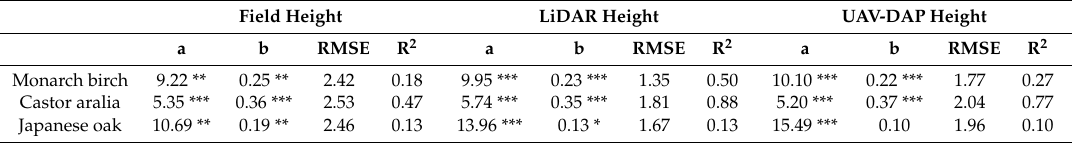
Table 7. H-D models using tree height derived from field survey, LiDAR and UAV-DAP data.